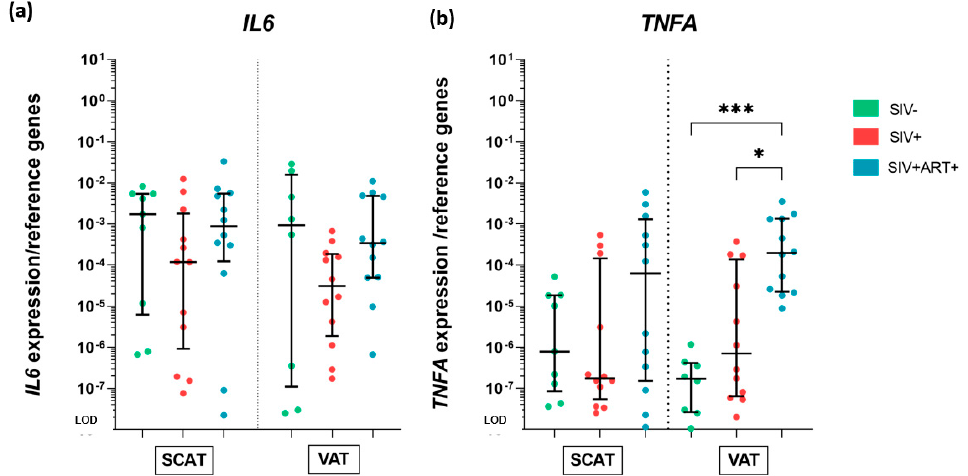
Figure 4. Gene expression analysis of cytokine production by the AT, at the whole-tissue level. RT-qPCR analysis of the mRNA expression of genes encoding the proinflammatory cytokines IL-6 and TNF- α within SCAT and VAT in the three groups of animals: SIV − (green), SIV+ (red), and SIV+ART+ (blue). The expression of the genes of interest was compared with that of the 18S and PPIA housekeeping genes. The LOD was set to the difference vs. the mean level of housekeeping gene expression after 20 cycles, i.e., a 10 − 8 -fold difference. ( a ) Expression of IL6 in SCAT (left) and VAT (right) in the three groups. ( b ) mRNA expression of TNFA in SCAT (left) and VAT (right) in the three groups. The results are quoted as the median [IQR]. Kruskal–Wallis tests associated with Dunn’s multiple comparison test or Mann–Whitney tests were used for unpaired and paired comparisons, respectively. Only significant results and trends are shown: * p < 0.05, *** p < 0.001.